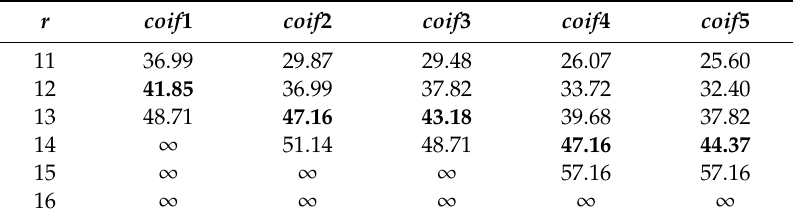
Table 7. Calculation results ( PSNR , dB) of 3D medical images (with 8 BPC) DWT by using bit-width r of coiflets filters coe ffi cients.